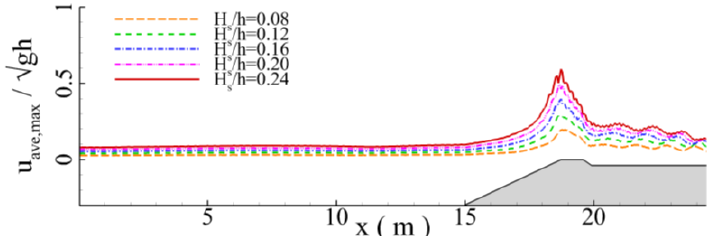
Figure 19. Space distributions of the local maximum local wave heights.